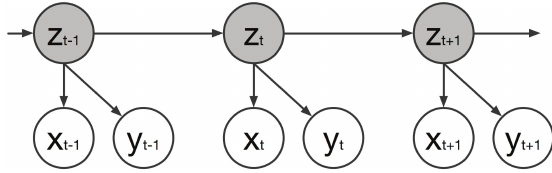
Figure 6. The DBN representation of the multivariate HMM used in the presented